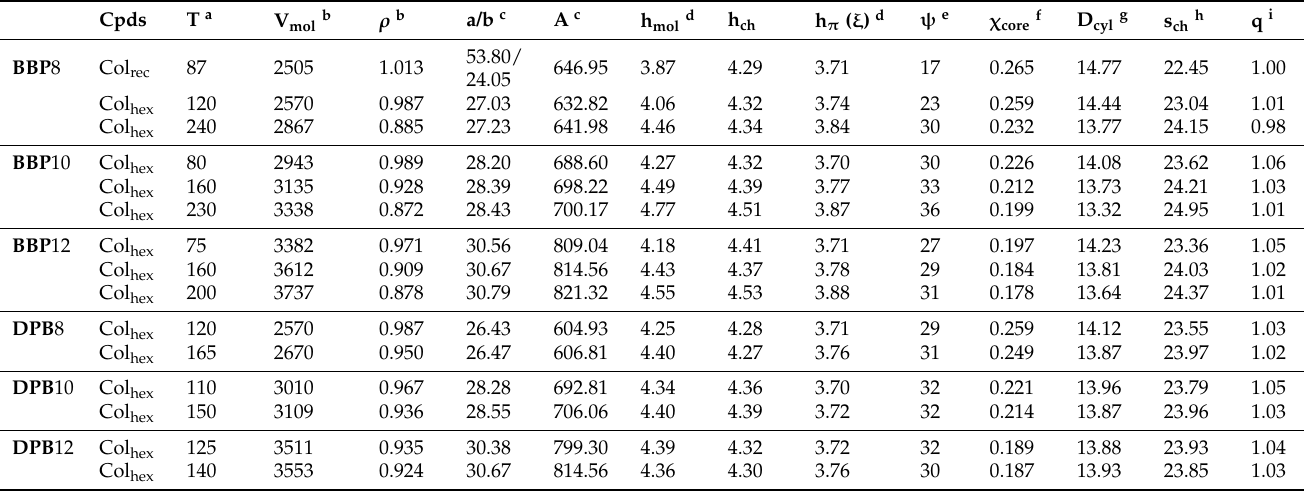
Table 1. Compounds and mesophase parameters and geometrical